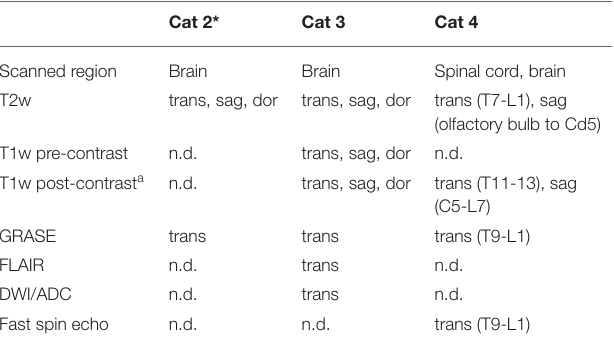
TABLE 2 | Magnetic resonance imaging (MRI) sequences and planes used for each cat. Cat 2*